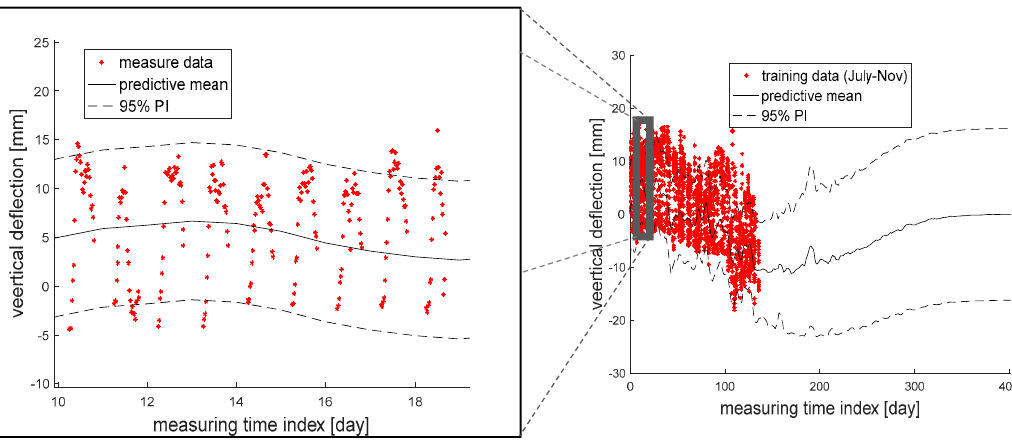
Figure 5. Analysis results of predictive mean and 95% prediction interval (PI) from the entire measurement data ( right ) and its zoom-in view ( left ).